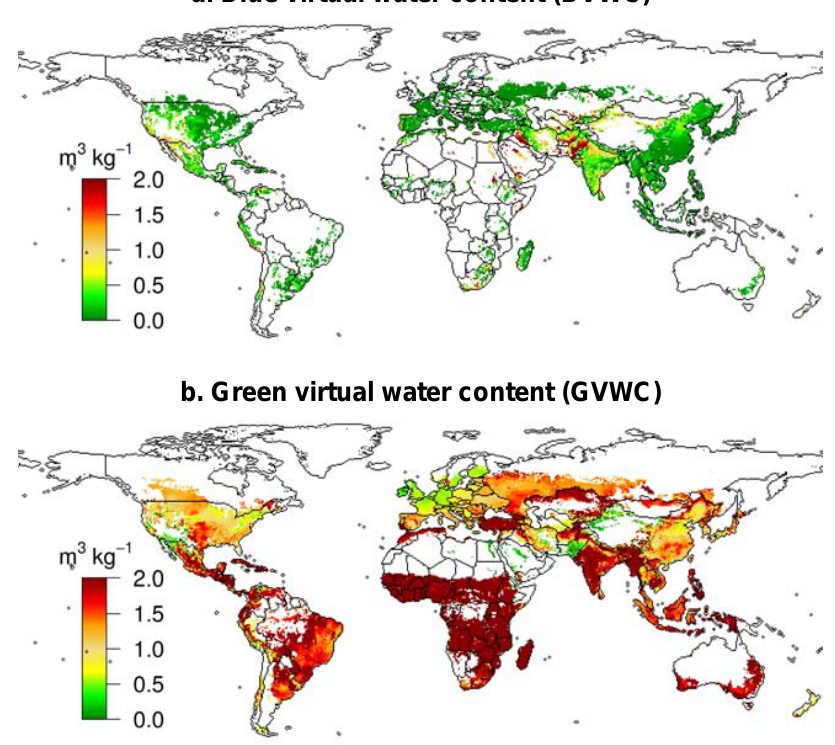
Fig. 2. LPJmL-simulated blue (a) and green (b) virtual water content shown as average over all CFTs, 1998–2002 period and 0.5 ◦ resolution.